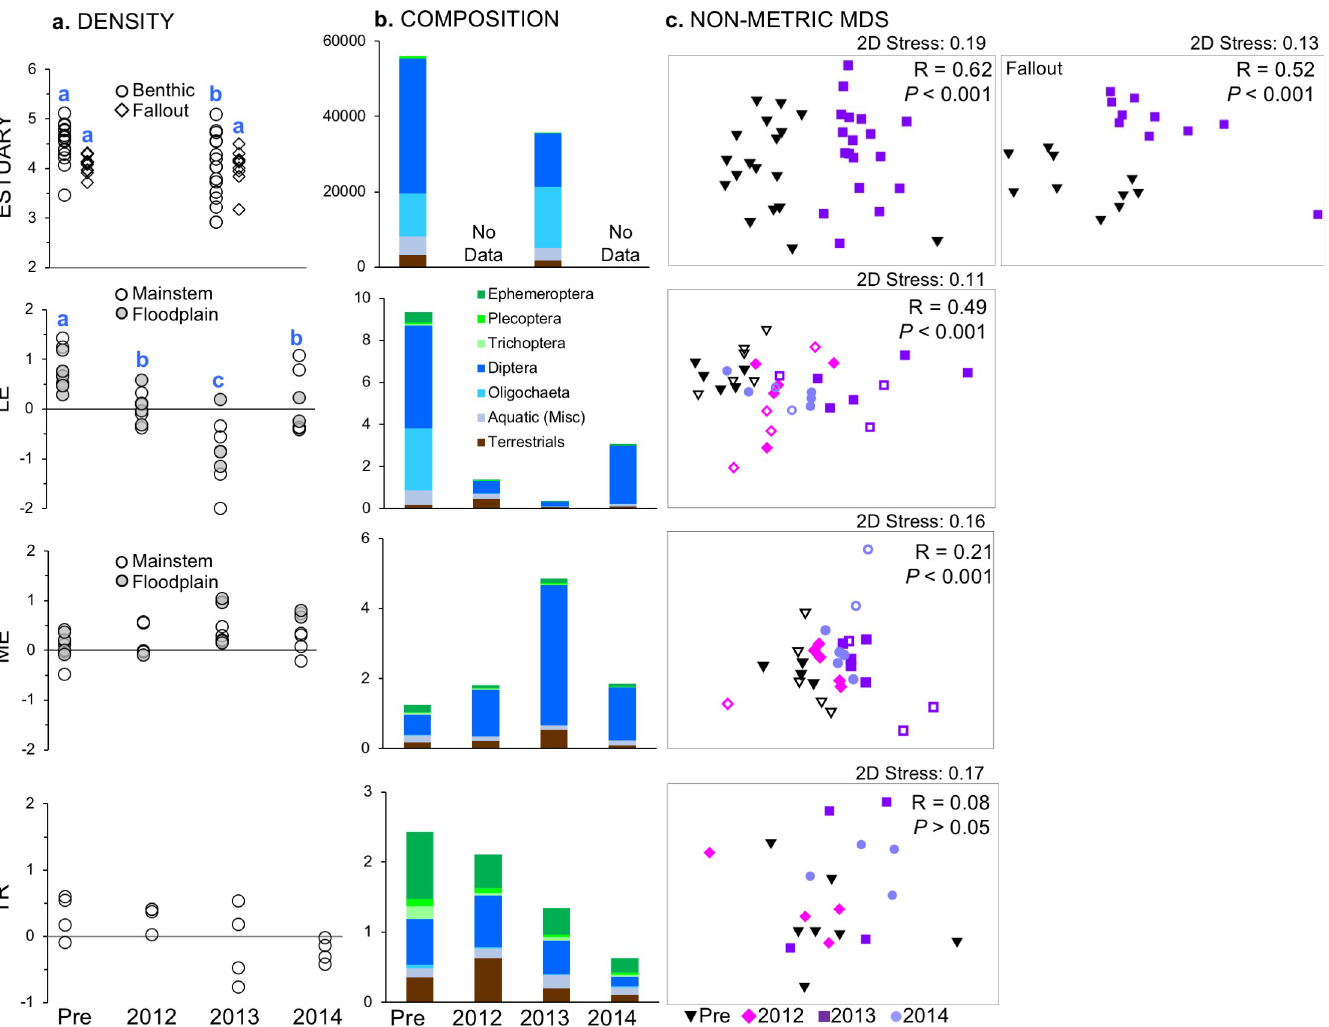
Fig 4. Summer invertebrate density by section and sample year. Data are plotted as (a) log density by site, (b) composition by major taxonomic groups (section means), and (c) nMDS, with global sample statistic and significance for one-way ANOSIM by year. For panel a, different letters indicate significant year differences ( P < 0.05) within a section based on Tukey’s HSD. Note that y-axis range varies by section, and that collection methods varied between estuary and river sections. For panel c, floodplain sites are indicated with outlined symbols. All data are based on numerical density: counts per m 2 for estuary and per m 3 for all other sections. For estuary data, composition data in panel b is combined for benthic and fallout